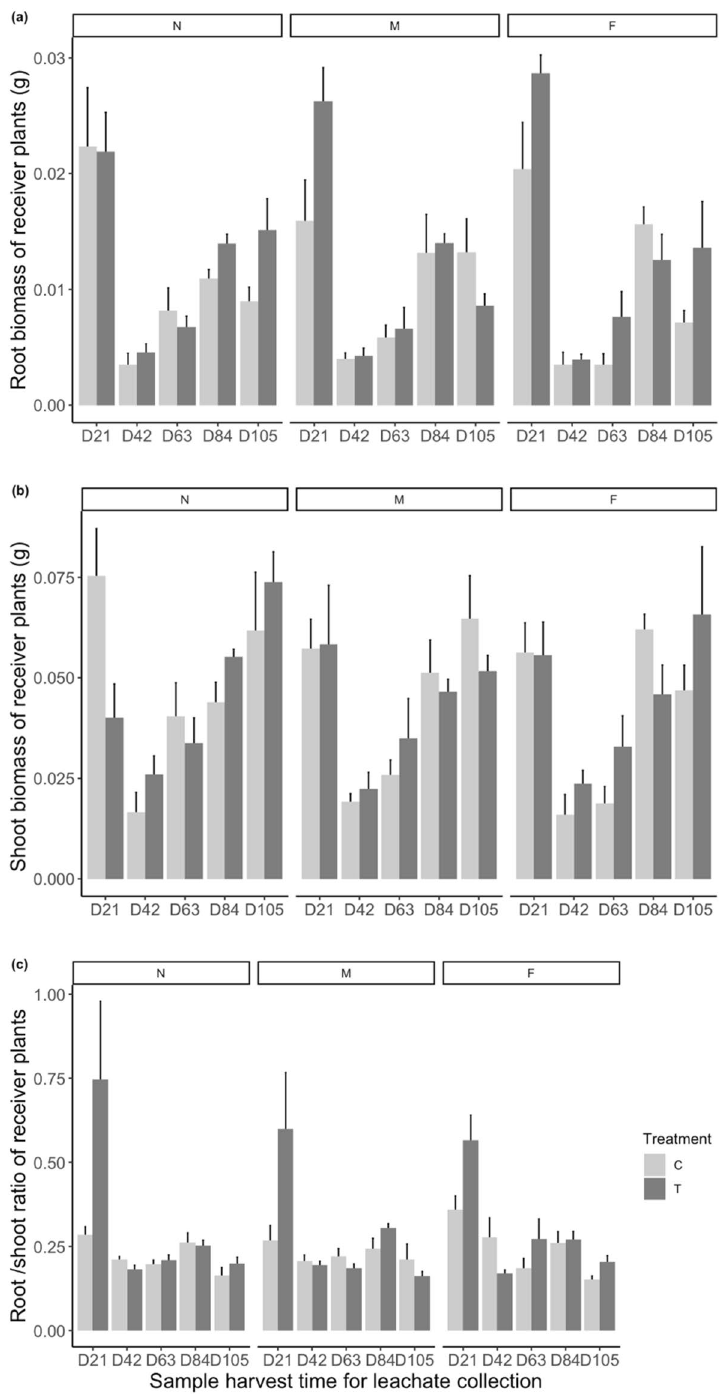
Figure 2. Effect of timing of leachate collection, location of leachate collection and nematode infection on the root biomass ( a ), shoot biomass ( b ) and root/shoot ratio ( c ) of receiver plants. T = leachates from nematode- infected plants, C = leachates from control plants; D21, D42, D63, D84, D105 indicate the leachate collection time in number of days (D) after nematode inoculation or water addition. N, M and F indicate the distances from the focal plant for leachate collection (N = 5–15 cm, M = 15–25 cm, F = 25–35 cm). Bars are means ± SE (n =